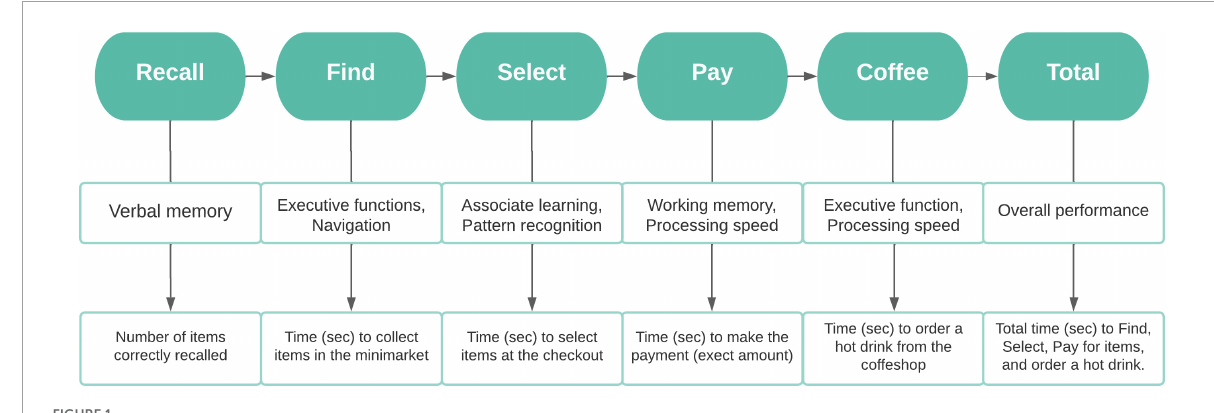
FIGURE1 Flowchart depicting the steps required to complete VStore, its corresponding cognitive domains, and outcome variables. © Porffy et al. (2022b). Originally published in the Journal of Medical Internet Research (https://www.jmir.org), January 26, 2022. This is an open-access article distributed under the terms of the Creative Commons Attribution License (CC BY 4.0).